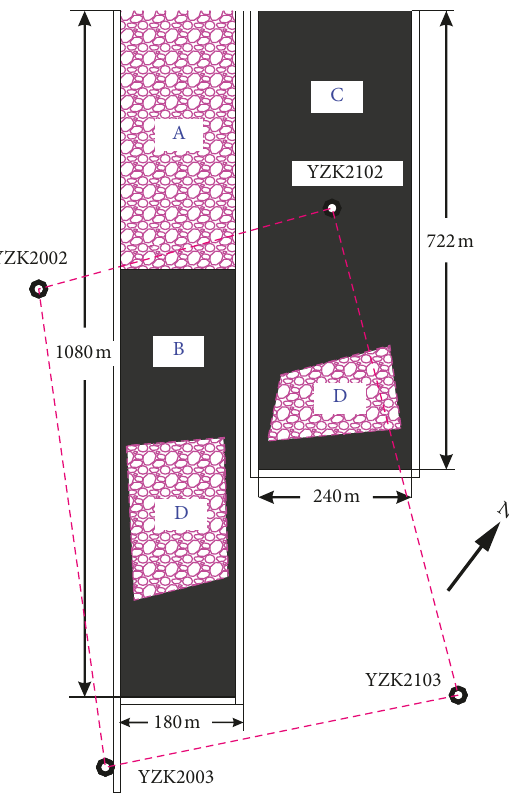
Figure 5: Projection plane depicting the spatial relationship be- tween the gob in the #4 seam and the panels in the #6 seam. A: longwall mining gob in the #4 seam; B: mining area of the 6104 fully mechanized face; C: the 6105 fully mechanized face; D: the room mining gob in the #4